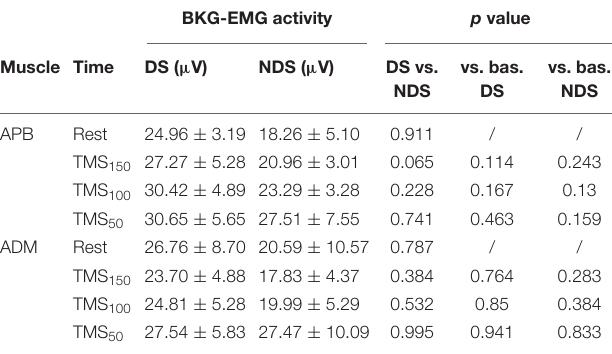
TABLE 3 | Background EMG activity at rest and after TMS.